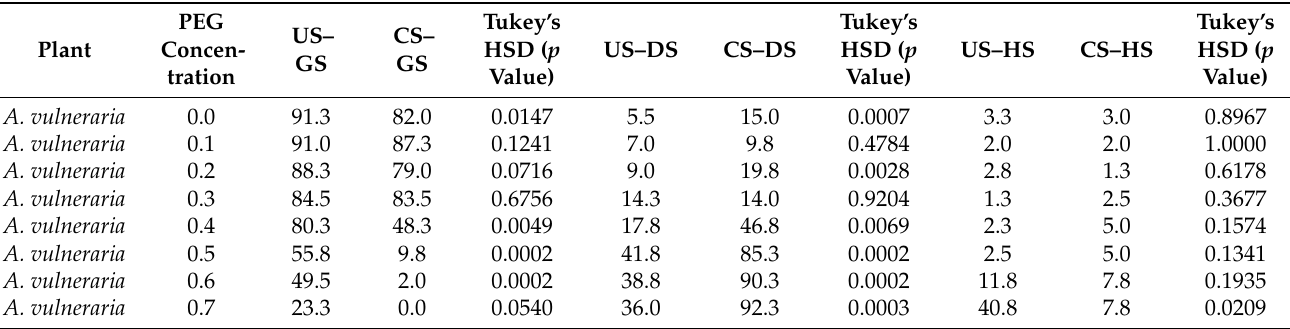
Table A5. Results of Tukey’s HSD test— A. vulneraria .